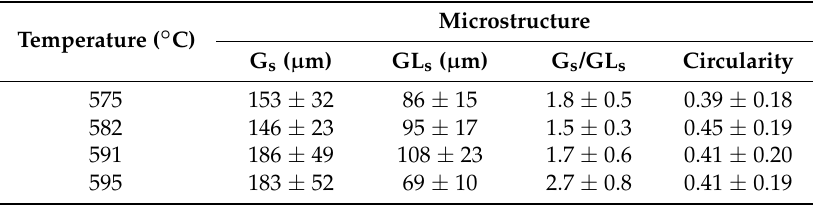
Table 5. Microstructural parameters of B319+Fe alloy samples heat-treated for 60 s at four temperatures.